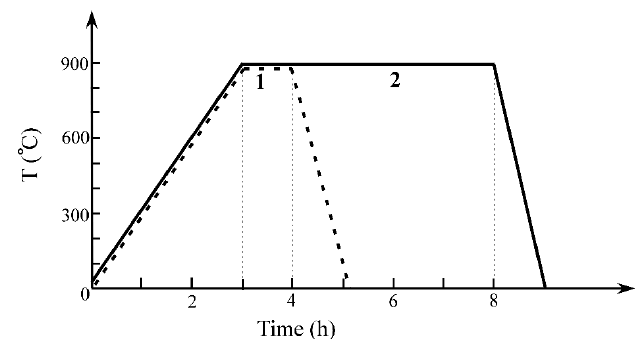
Figure 8. Preoxidation procedures of the CMSX-4 superalloy (temperature vs time), and procedure 1